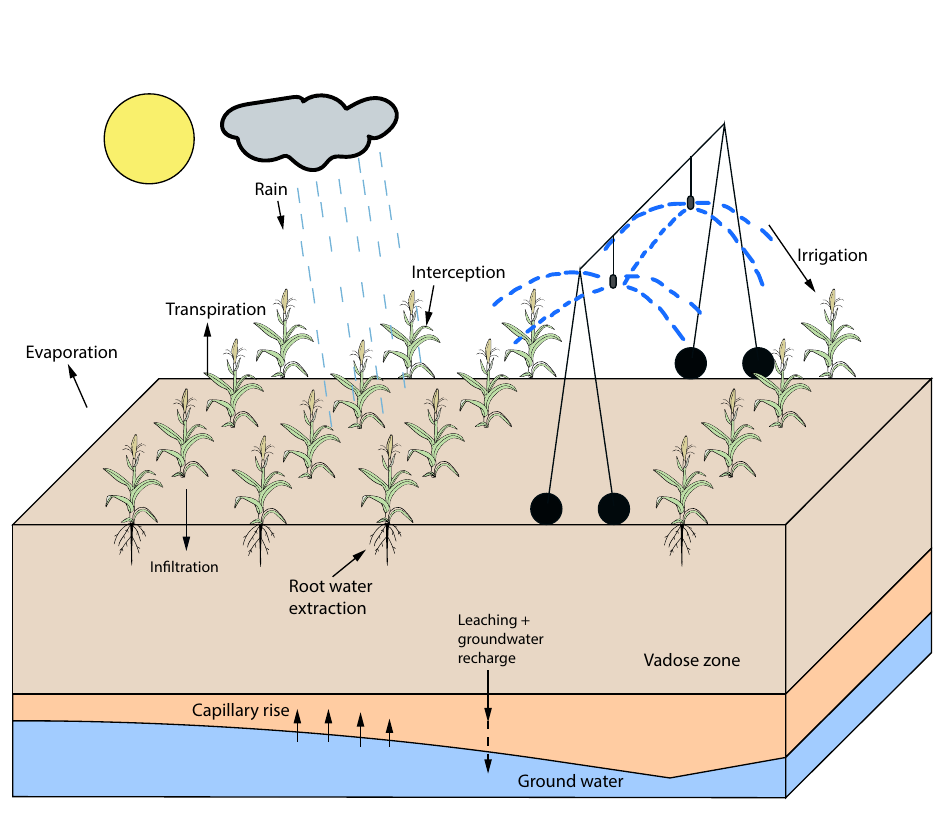
Figure 1. A schematic diagram of a 3D agro-hydrological